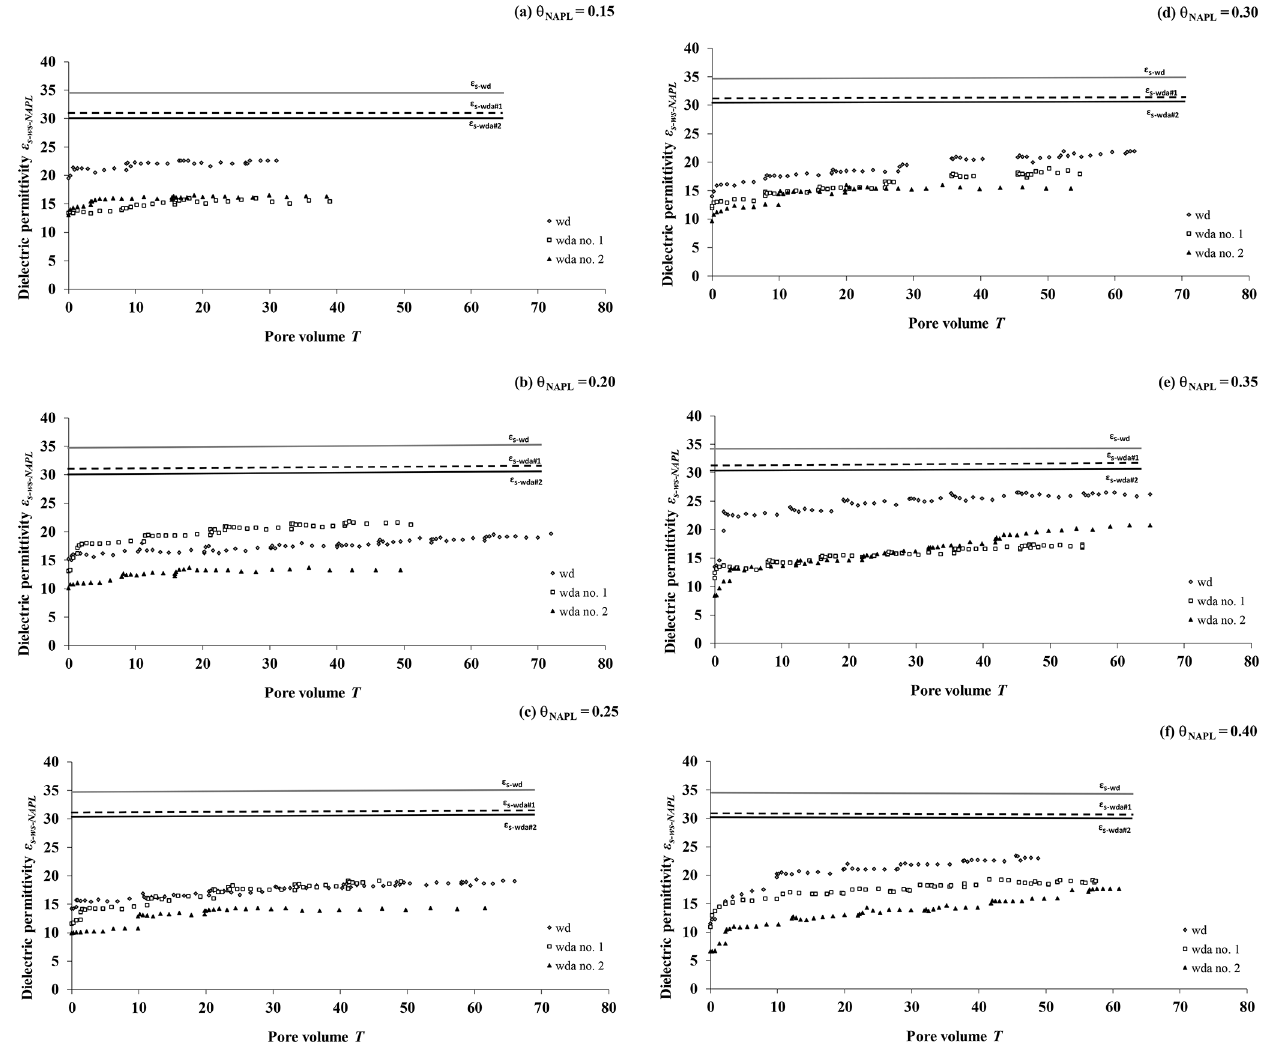
Figure 2. Selection of experimental relationships between the measured dielectric permittivity ( ε s-ws-NAPL ) and number of pore volumes T under the effect of different washing solutions: (i) water–detergent (wd) and (ii) water–detergent–alcohol (wda no. 1 and wda no. 2).